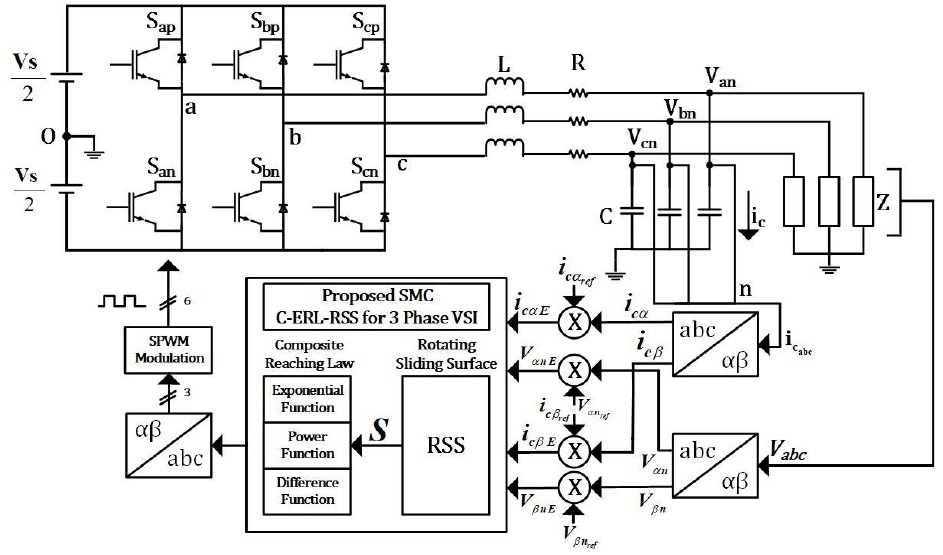
Figure 2. Three phase VSI with the proposed reaching law based SMC. System Modeling for Three Phase VSI